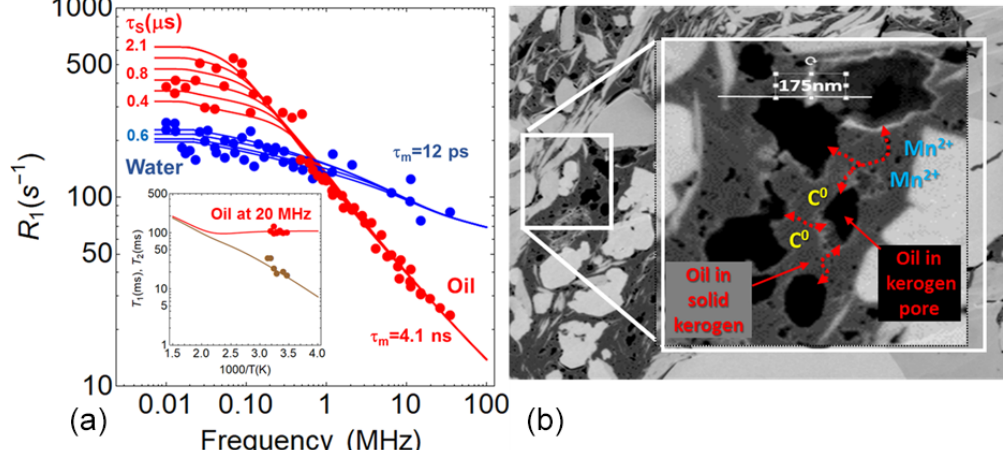
Figure 8. (a) NMRD profiles of liquids obtained on an “as received” shale (oil in red, water in blue), representing the variation of the longitudinal relaxation rate 1 /T 1 versus the frequency. The inset shows the temperature dependence of relaxation times T 1 (red) and T 2 (brown) at 20MHz for oil obtained on another “as received” shale. The continuous lines are the best fits obtained with the model described in the Supplement, with τ m and τ s the translational and surface residence times, respectively. (b) Representation of the diffusion–relaxation modeling of oil in the connected pores of